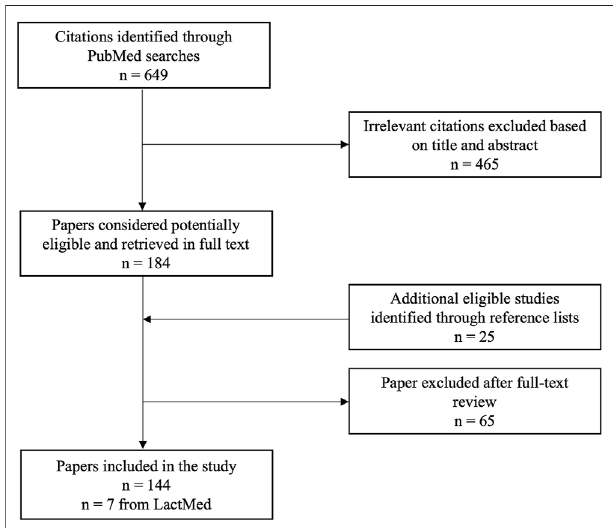
FIGURE 1 | Literature review fl ow